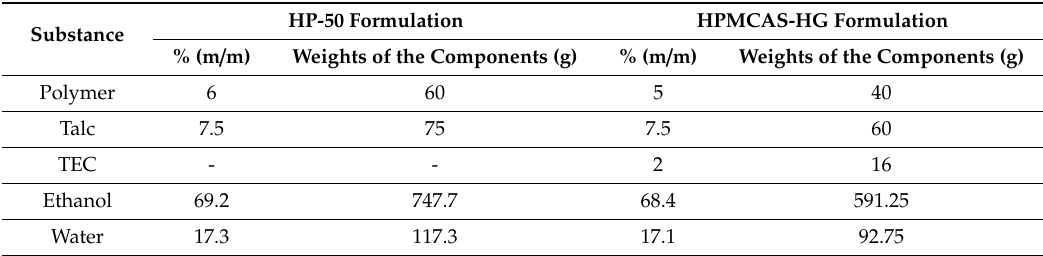
Table 2. Coating formulation. All values (%) are based on the total